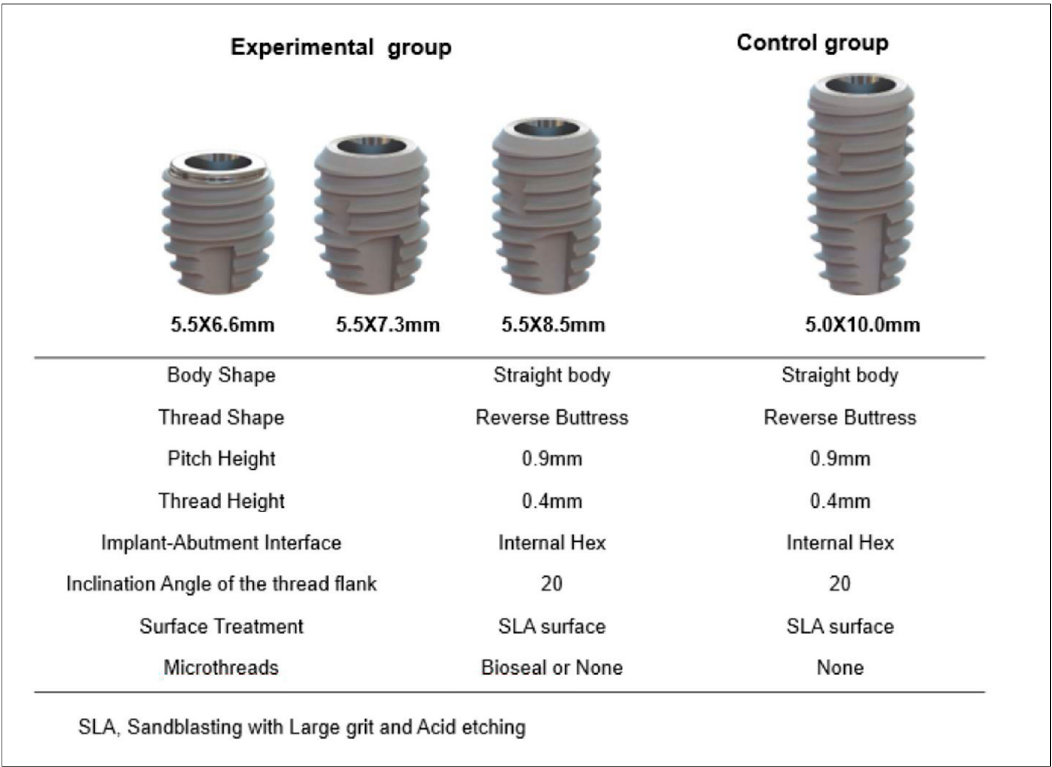
Figure 1. Characteristics of the implants systems used in this study: CMI IS-III active ® (Neobiotech, Seoul, Korea), short and long implants.